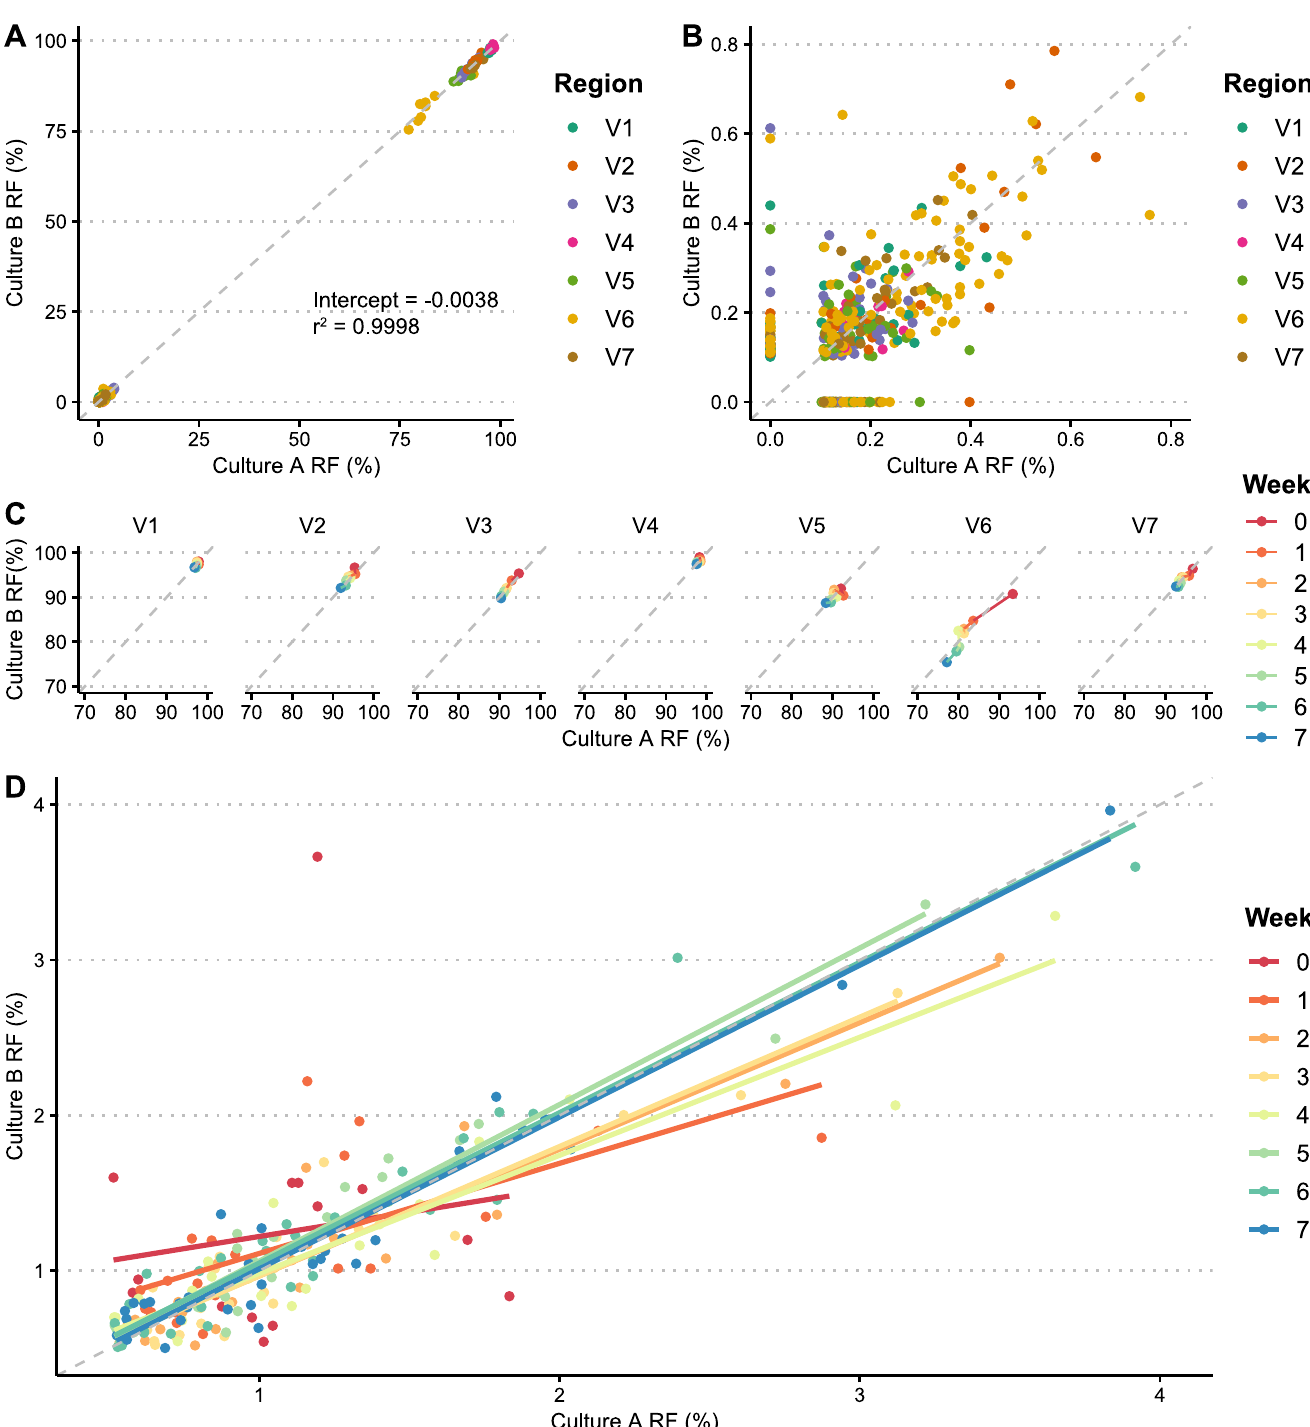
Fig 6. Similar relative frequencies (RFs) of tprK variable region alleles are observed across culture replicates. (A) Comparison of relative frequencies of alleles between two sets of culture passages. Dots represent unique variable region sequences of varying timepoints, color-coded by region. Dotted gray line plots Y = X. (B) Comparison of relative frequencies of all novel alleles not in inoculum between two culture replicates, color-coded by variable region. (C) Relative frequencies of alleles between both culture replicates, at over 70%. Data are grouped by variable region and color coded by week. (D) Correlation between relative frequencies of alleles in culture replicates at low frequencies over time. Dots represent unique variable region sequences between timepoints, with corresponding regression lines plotted. Both are color-coded by week.